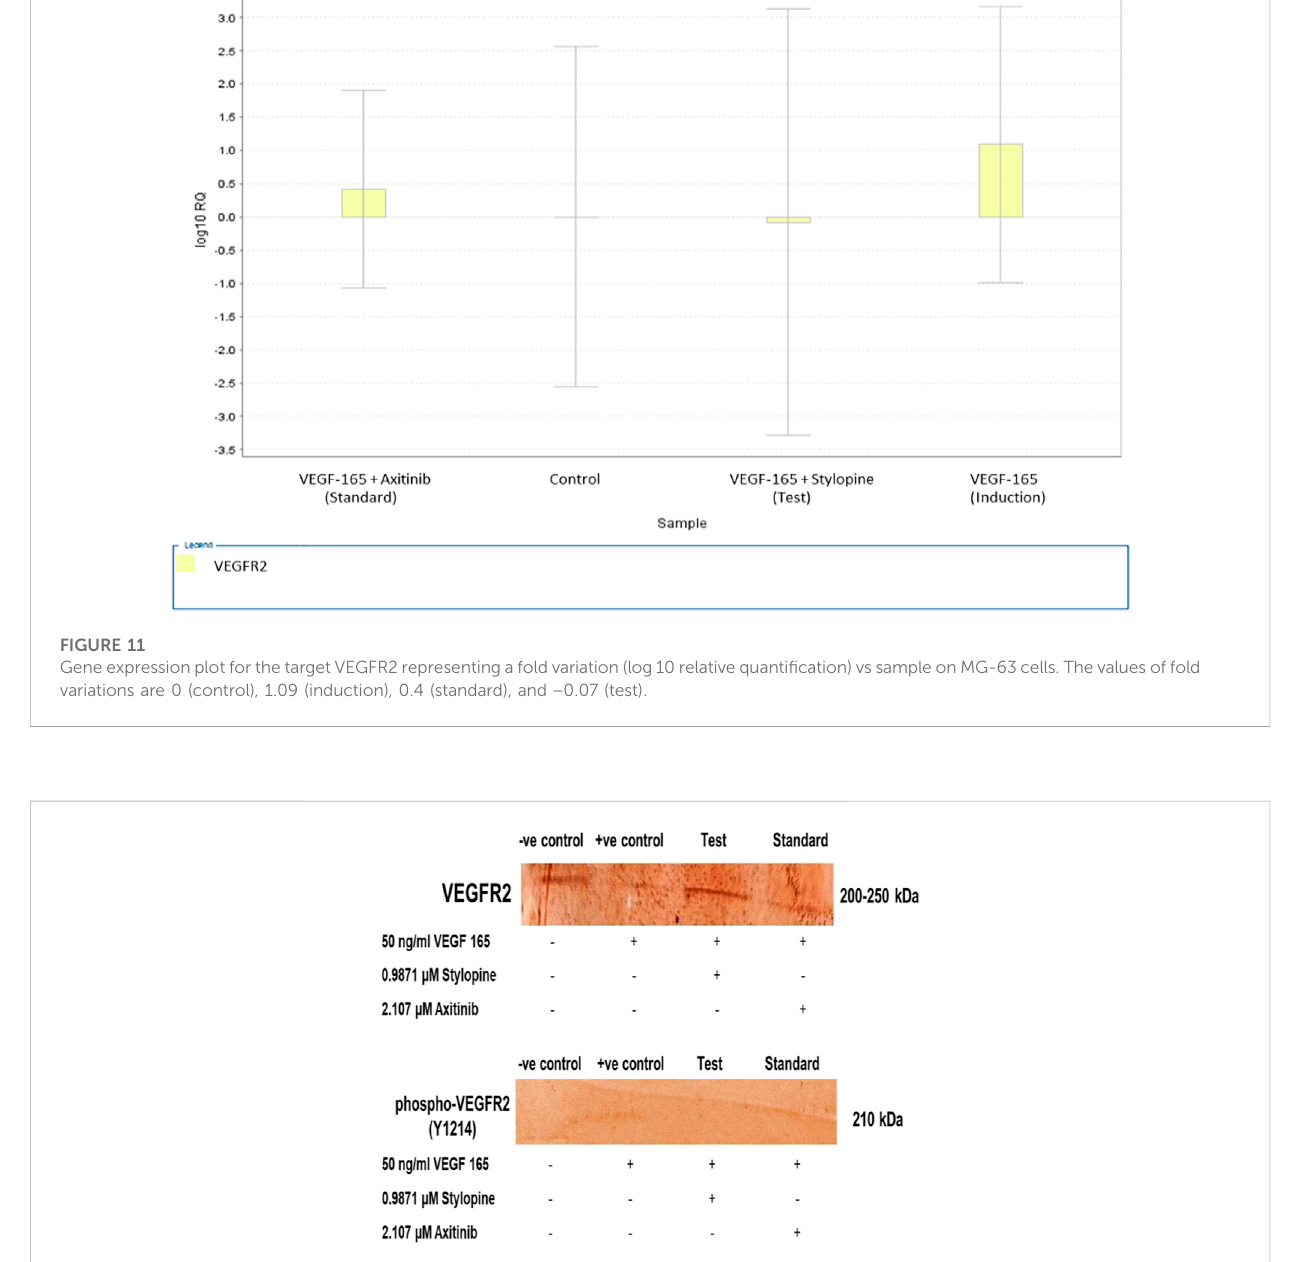
Target protein expression on MG-63 cells using SDS-PAGE followed by immune-blotting and DAB